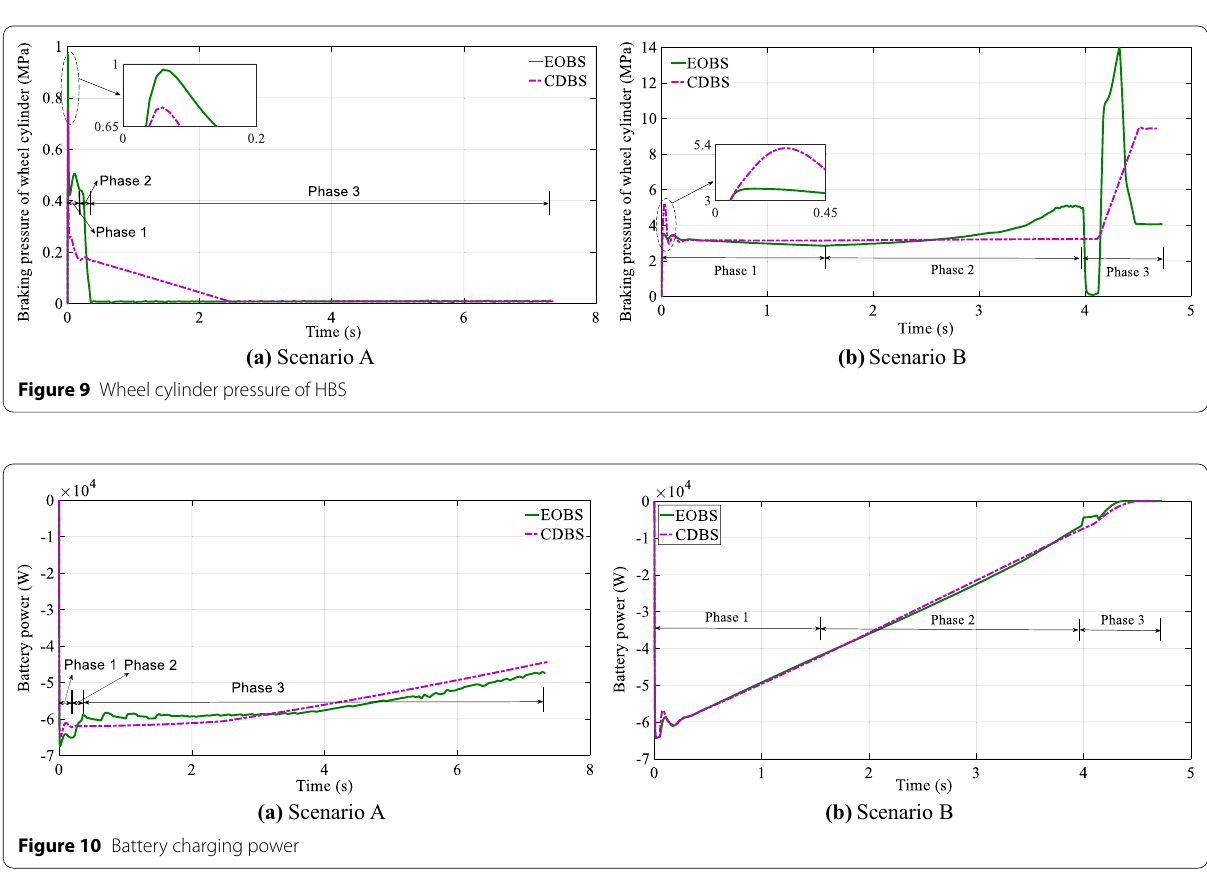
Table 4 Efficiency of motor (%) Front axle Rear axle Average Scenario A EOBS 90.59